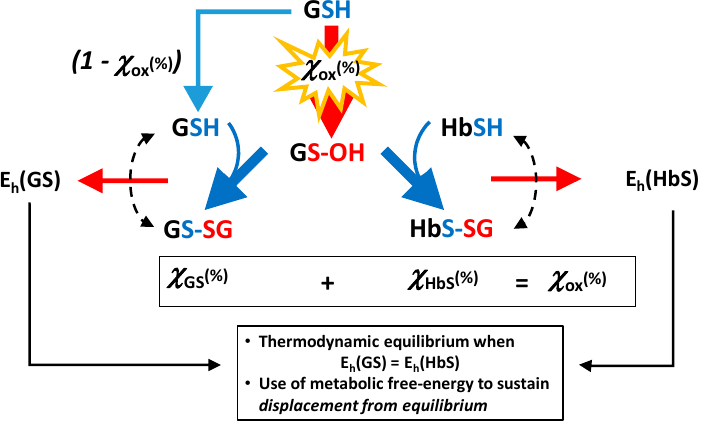
Figure 6. Partial scheme of the formation of oxidized glutathione and glutathionyl-hemoglobin in oxidatively stressed red blood cells.